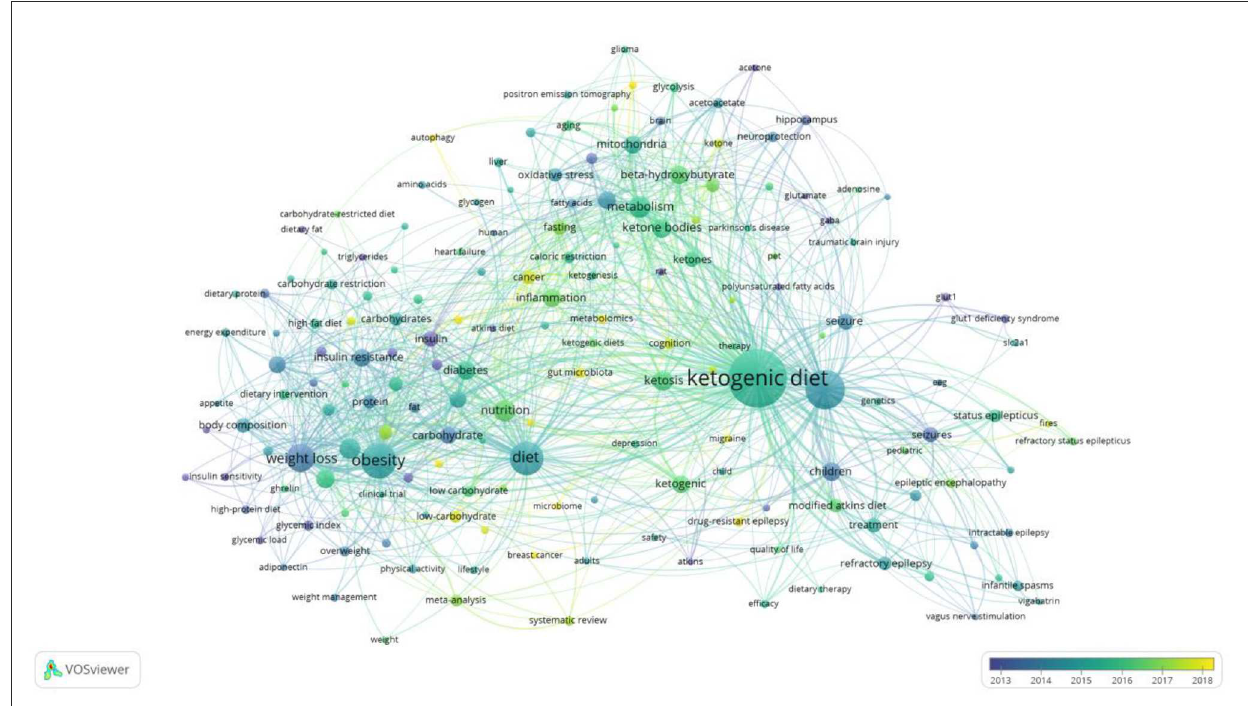
FIGURE8 Map of keyword co-occurrence of overlay visualization on LChD from 2002 to